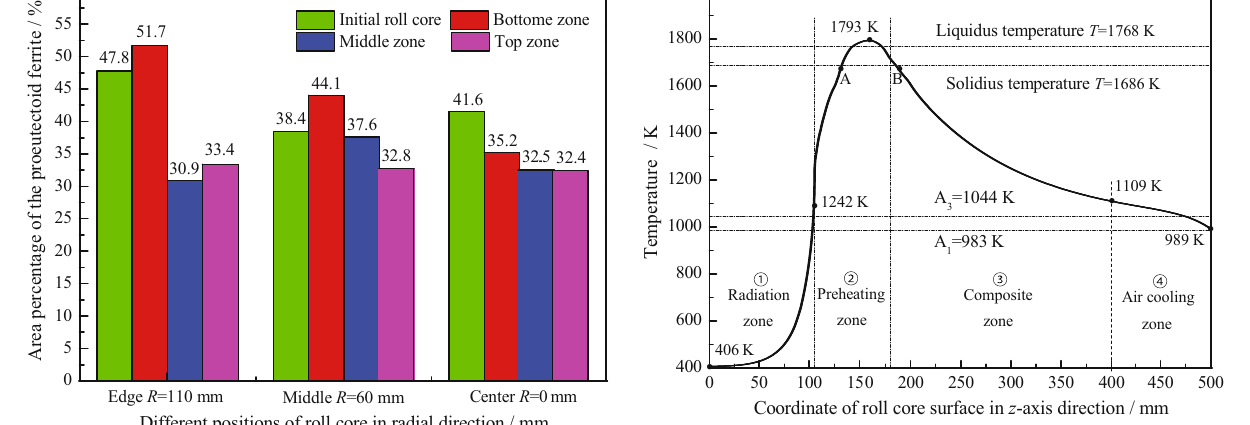
Figure 6: Proeutectoid ferrite content in the specimens taken from the roll core.